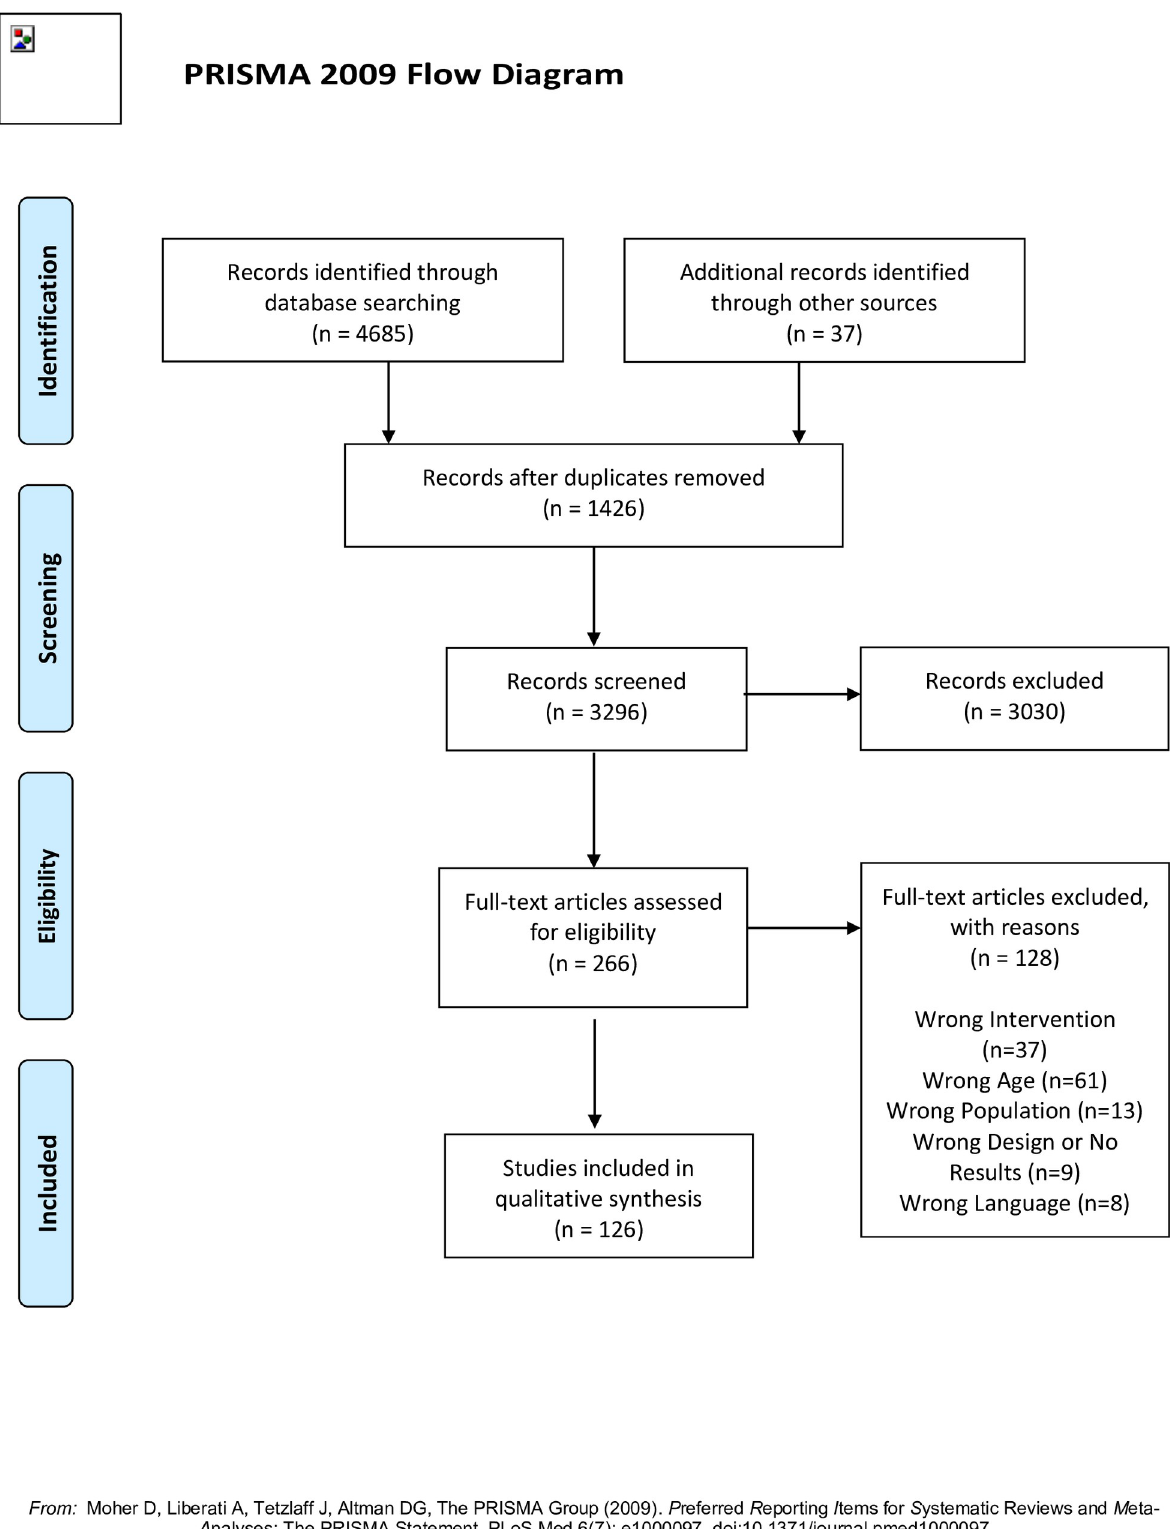
Fig 1. Prisma flow